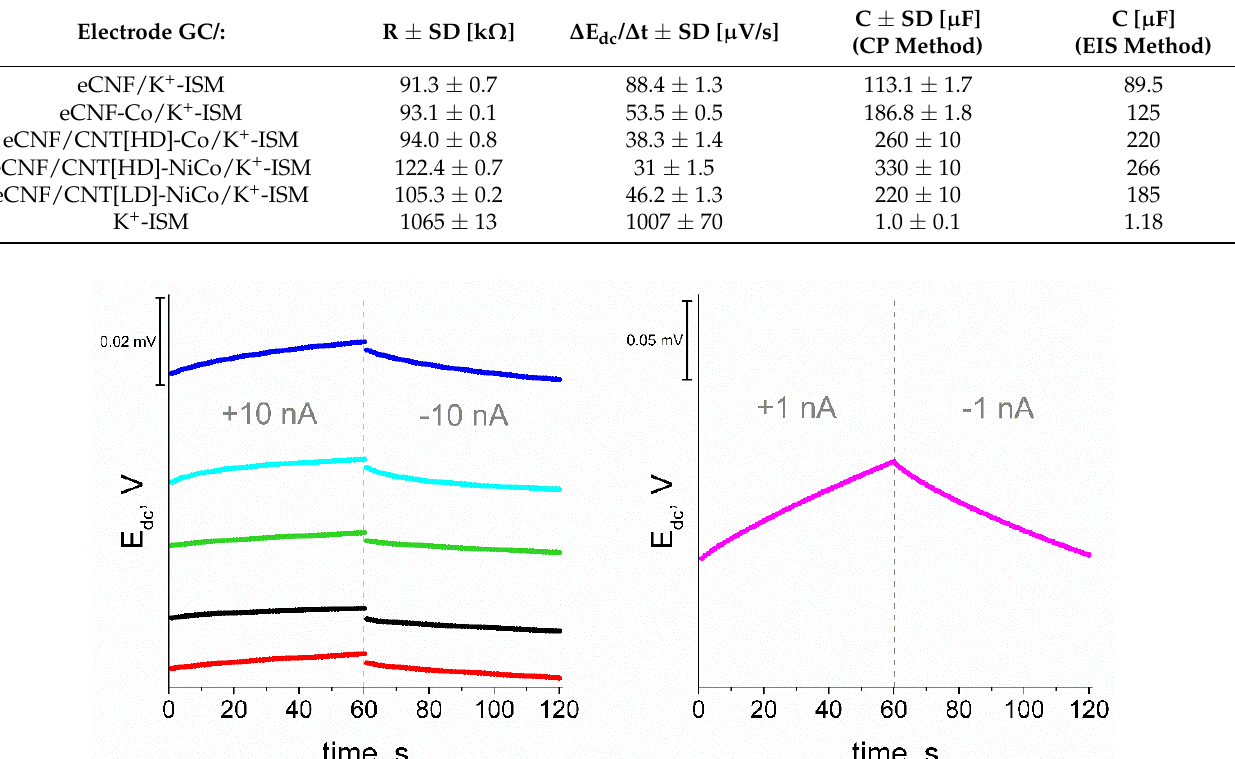
Table 2. Electrical parameters of the investigated K+ ‐ ISE.